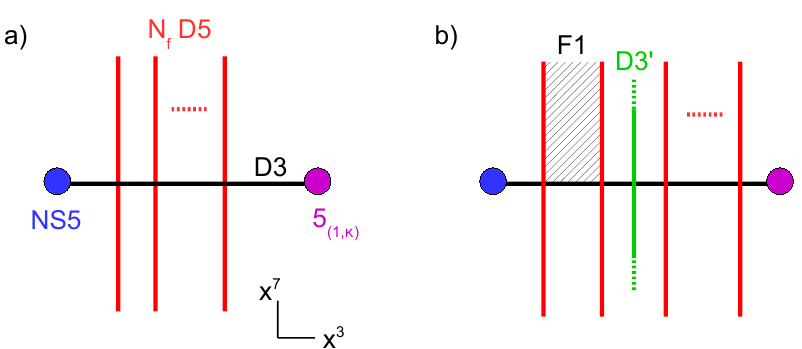
Figure 5 . (a) Brane con(cid:12)guration realizing the U(1) (cid:20) with N f (cid:13)avor hypermultiplets, in the ( x 3 ; x 7 ) plane. (b) The addition of F1 strings stretched between two D5s and/or D3’ branes crossing the D3 segment insert meson